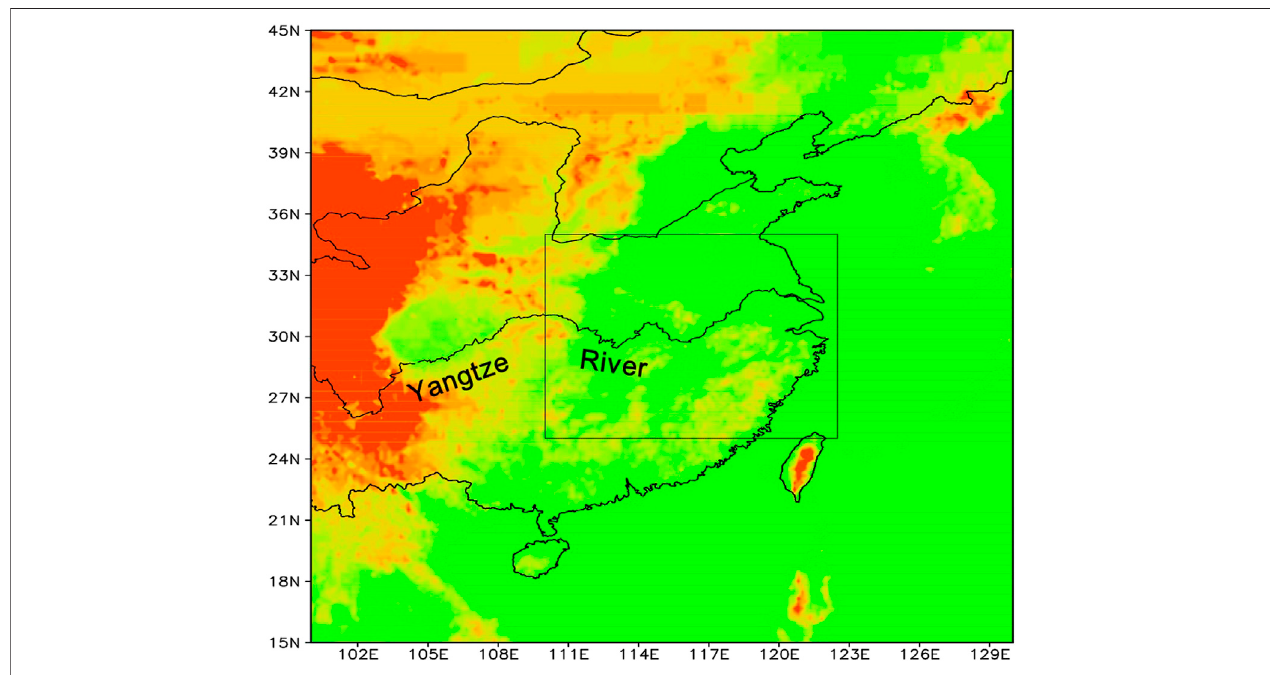
FIGURE 1 | Location of the study area. The color shading indicates the altitude (units: m) and the black rectangle indicates the MLRYR.